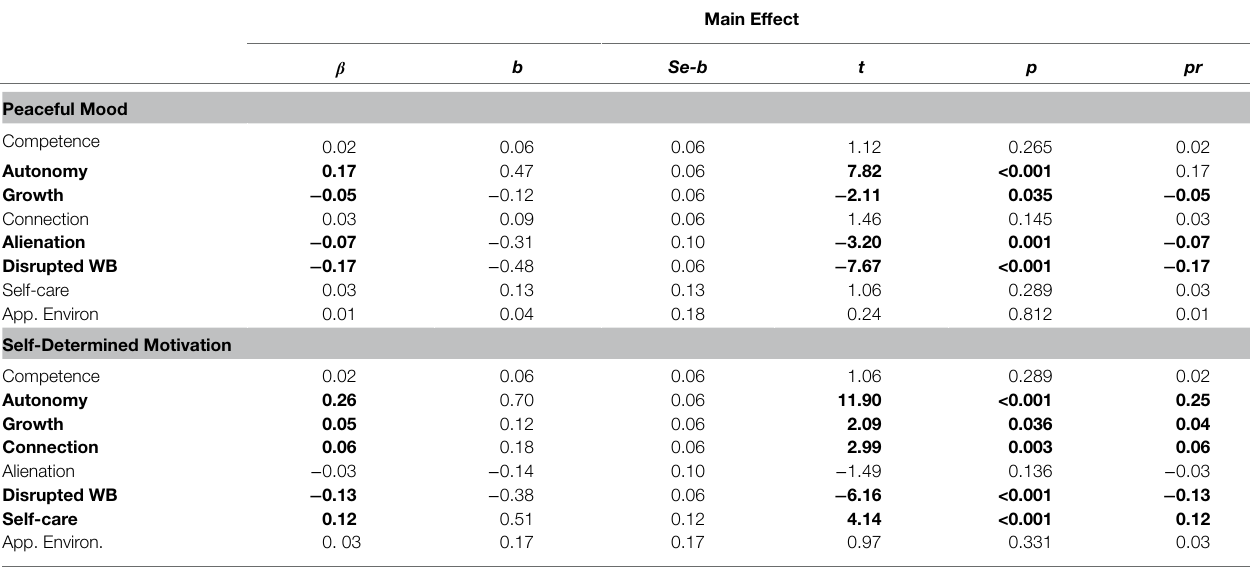
TABLE 3 | Main effects predicting well-being in solitude indicators: peaceful mood and self-determination